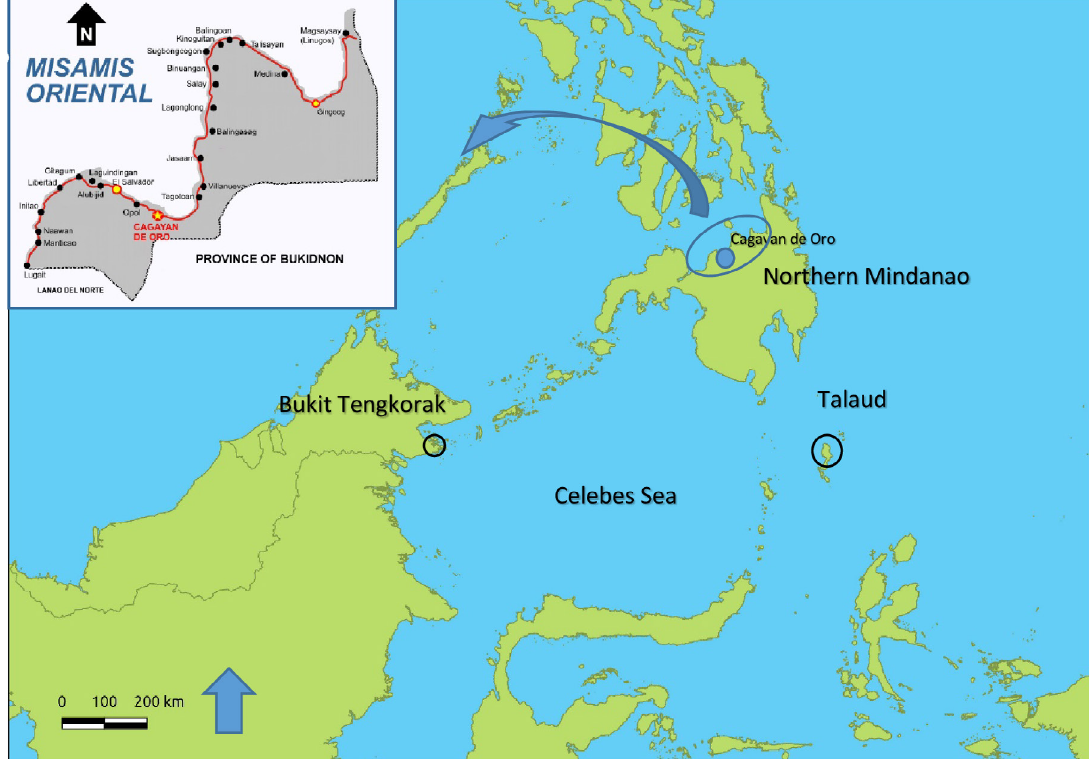
Figure 1. Map of the Celebes Region showing Northern Mindanao, Bukit Tengkorak, and Talaud Sites (Misamis Oriental map courtesy of